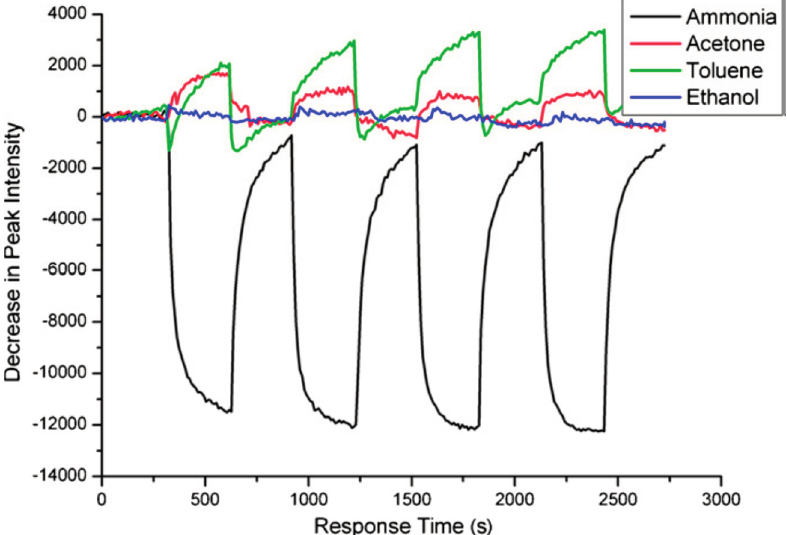
Figure 5. Optical response curve of the ammonia sensor to four kinds of gases. Reprinted with permission from Reference [52]. Copyright 2011 Elsevier